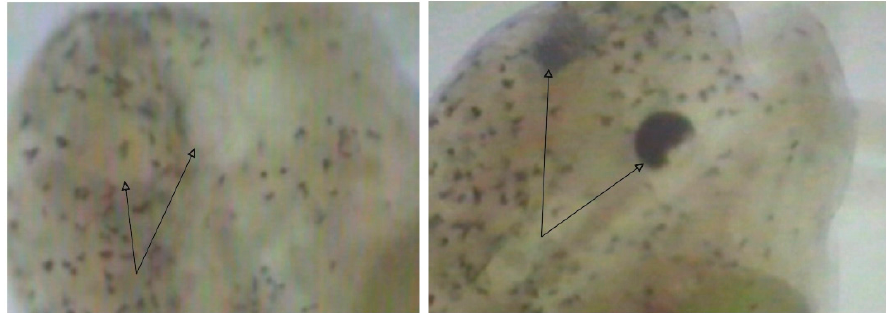
Figure 5. Eye pigmentation of African catfish larvae in ( left ) geomagnetic field (GMF) and ( right ) SMF—5 mT (used with kind permission from Adam Brysiewicz).